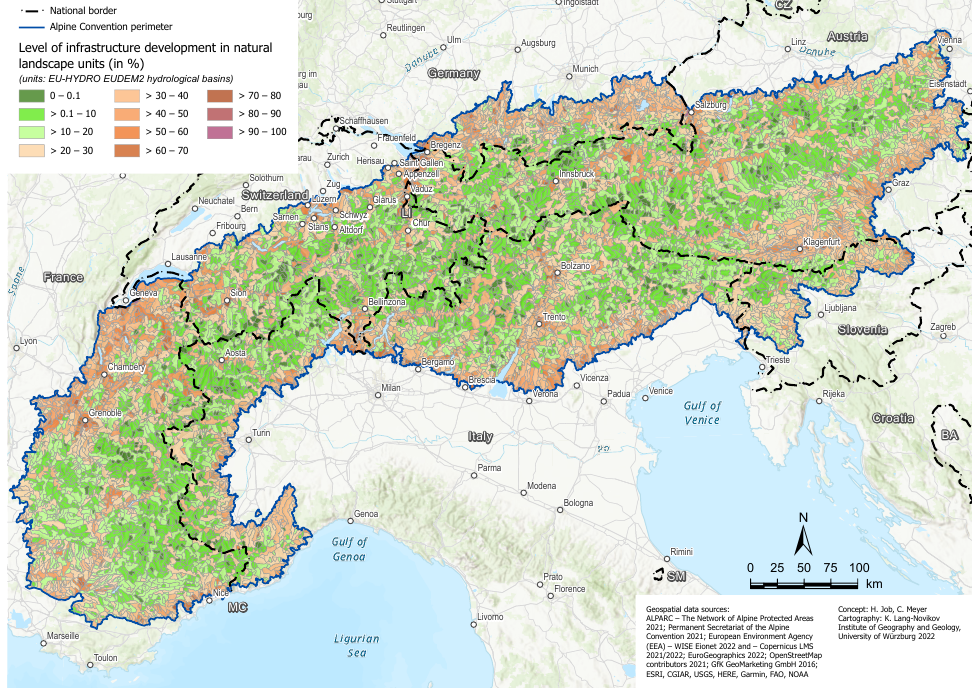
Figure 3. Level of infrastructure development in natural landscape units (hydrological basins) (source: authors’